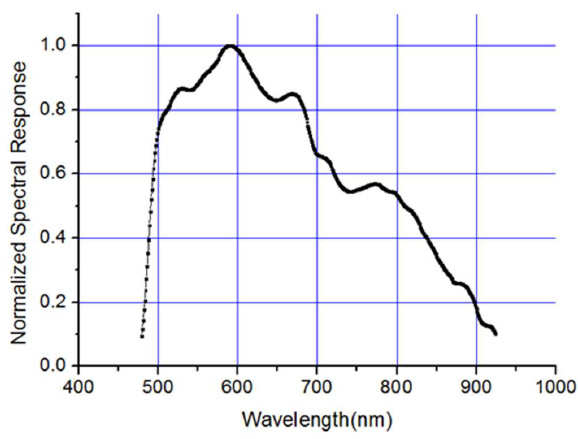
Figure 7. The relationship between MTF limited by diffraction and F number.